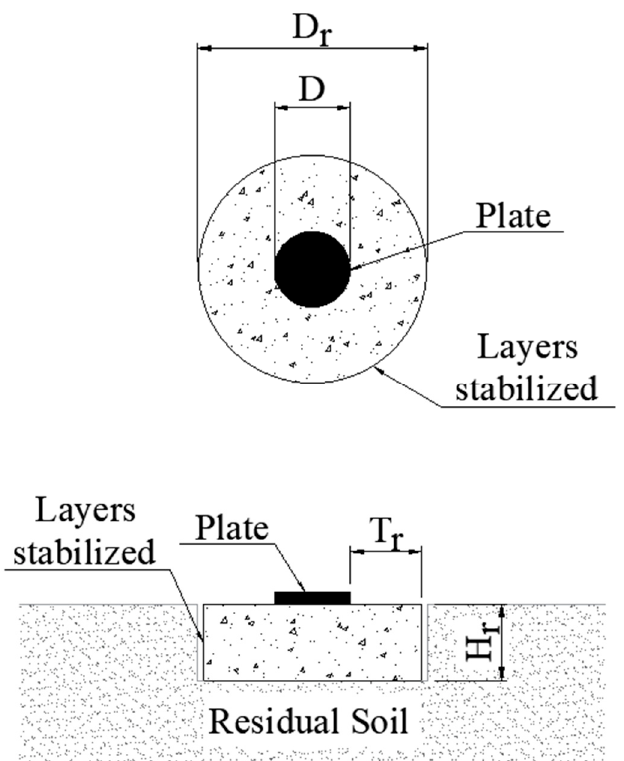
Figure 5. Geometry of the stabilized layers and Load Plate Test setup. The PLT procedure followed the recommendations of [56]. The load ( Q ) was applied using a hydraulic jack installed under a loaded reaction structure (Figure 7a,b). The readings were performed with a load cell, properly calibrated in the laboratory, and a data acquisition system. The measurement of the vertical displacement was performed using resistive rulers with a course of 50 mm and a resolution of 0.01 mm, positioned at three different points on top of the plate (Figure 7c). The load increments applied in each stage were previously defined as 10% of the expected rupture load. For the definition of the load capacity, the criterion of [18] was used, where the breaking load ( Q u ) is defined as the point on the stress–settlement curve corresponding to a relative settlement ( δ /D ) of